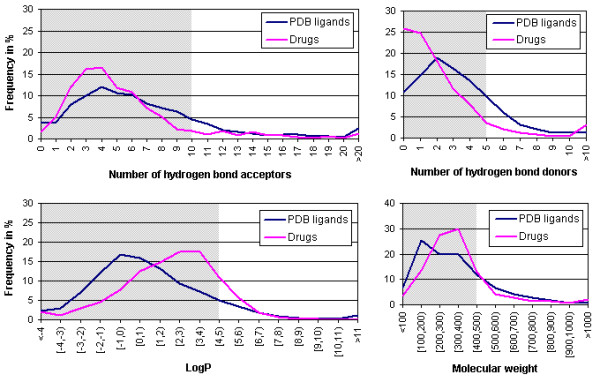
Statistics: comparison of PDB ligands with drugs. Chemical properties of 5040 PDB ligands and 2396 drug molecules are compared: histograms for numbers of hydrogen bond donors and acceptors, logP value and molecular weight are shown. Molecular weight within [100,200) means that the molecular weight is greater than or equal to 100 and less than 200. Those areas for which the Lipinski "Rule of 5" is fulfilled, are highlighted in grey.